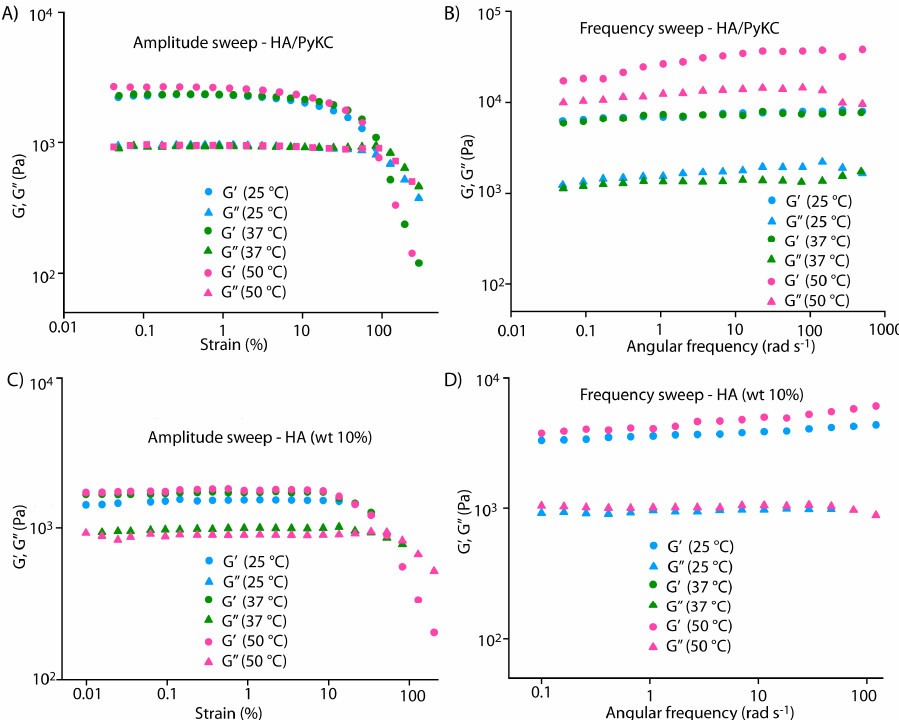
Figure 4. Temperature dependent amplitude sweep ( A , C ) and frequency sweep ( B , D ) of HA/PyKC and HA hydrogels